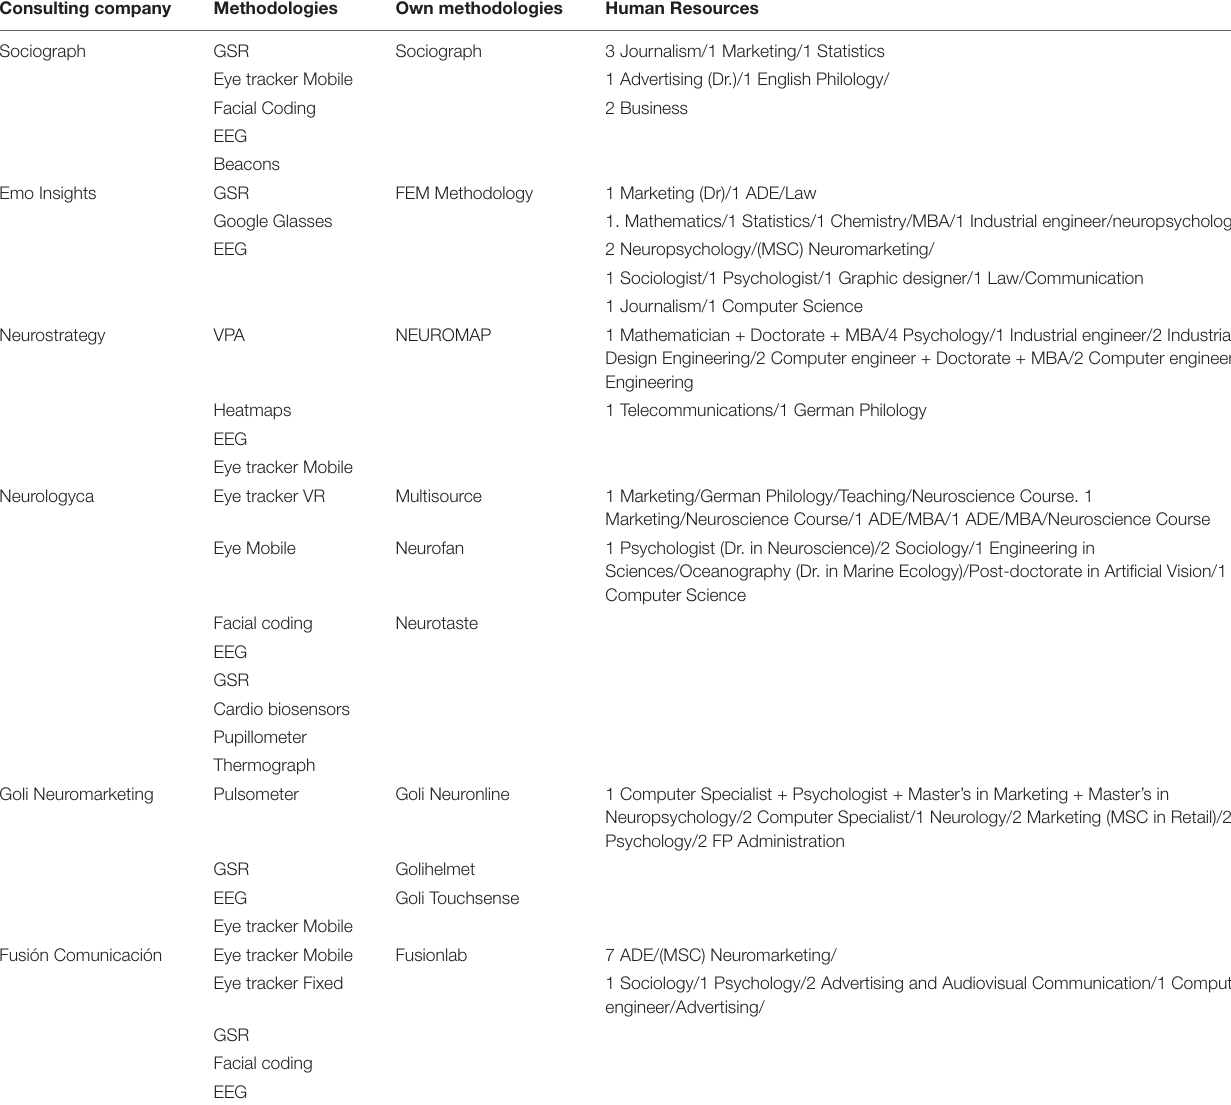
TABLE 6 | Combined table of data by consultant. Consulting